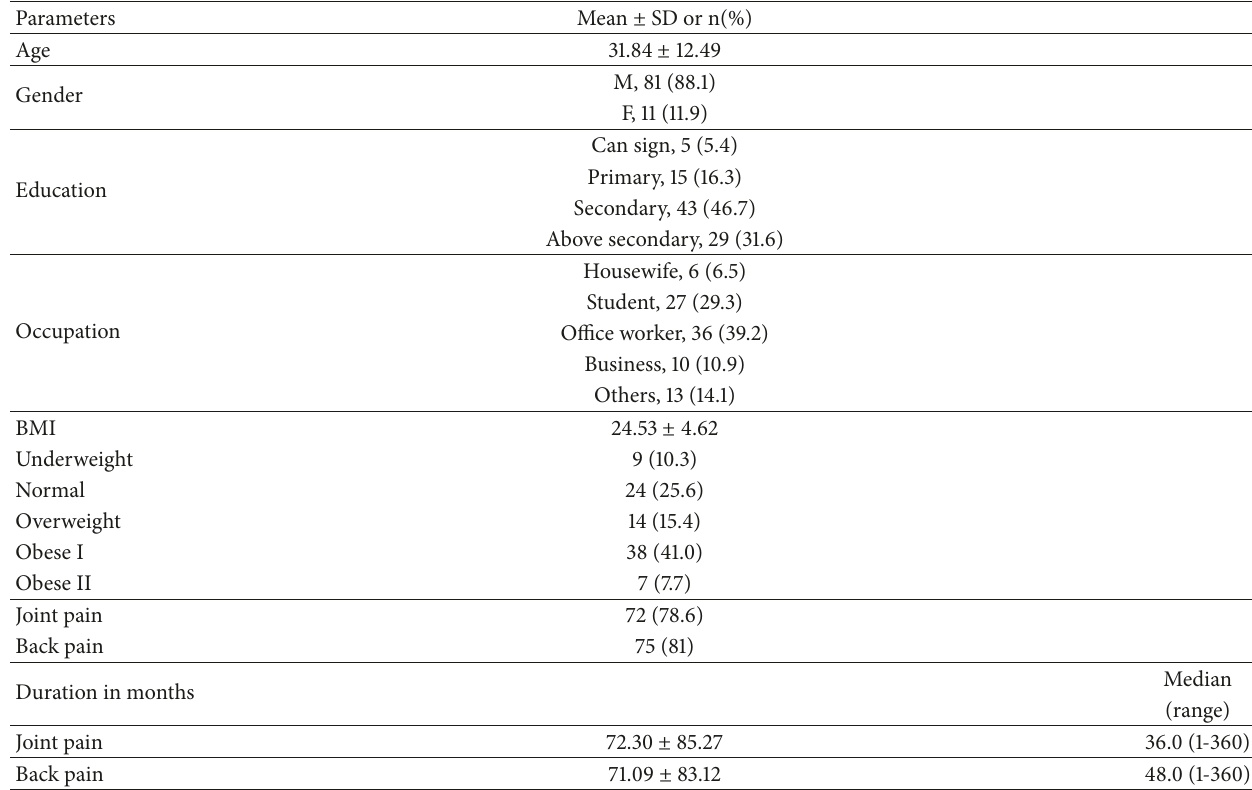
Table 1: Baseline demographic profile (n=92).